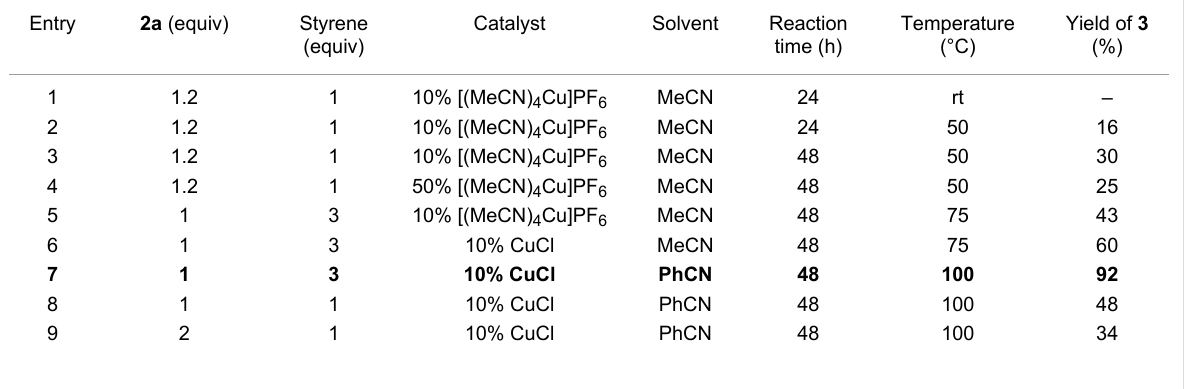
Table 1: Optimized addition reactions of 2a with styrene.